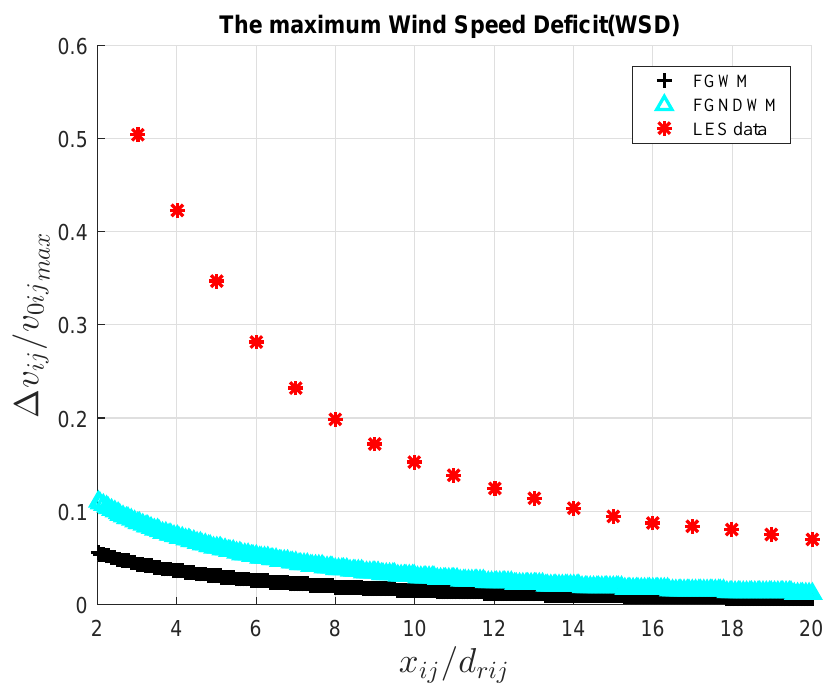
Figure 9. The portrait of the maximum Wind Speed Deficit (WSD) in Case e (fitted by LES data, i = 1,2, · · · , N ; j = 1,2, · · · , N